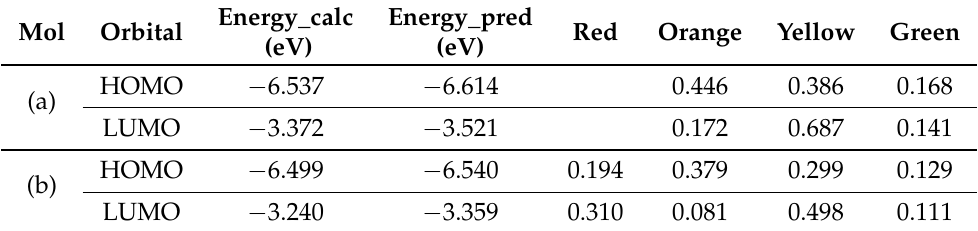
Figure 7. The structures of molecule ( a , b ) and their calculated HOMO and LUMO distributions. Table 2. The weighted sum of each fragment from the prediction model to the molecular orbitals for molecule (a) and